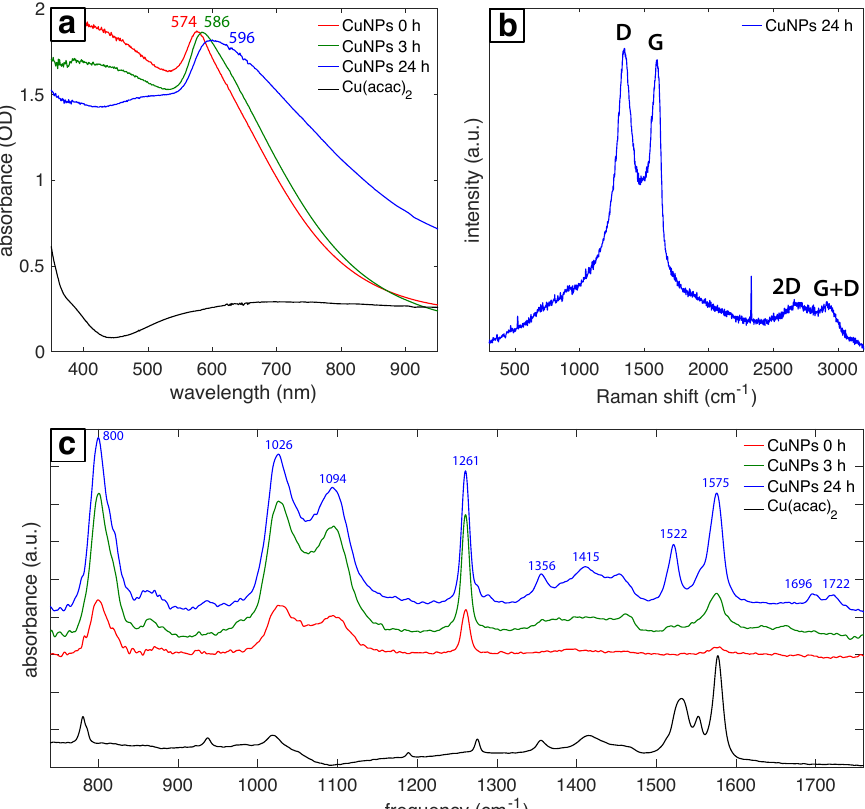
Figure 4. ( a ) UV-vis absorbance spectra for 0 h, 3 h, 24 h samples and precursor. ( b ) Raman spectra for 24 h samples. ( c ) FTIR spectra for 0 h, 3 h, 24 h samples and